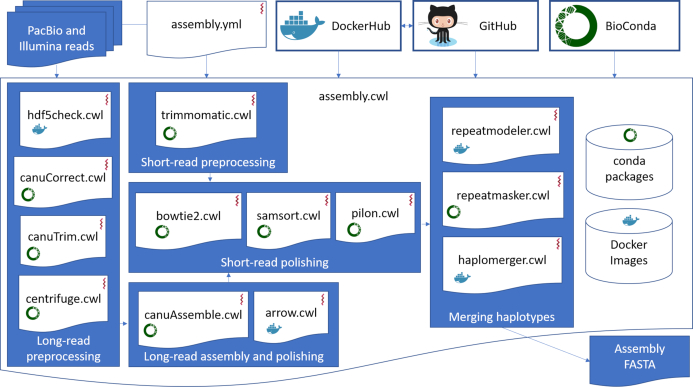
Diagram illustrates an automated common workflow language (CWL)-based genome assembly pipeline for PacBio long-read and Illumina short-read data. PacBio reads are first pre-processed and then used for assembly and long-read polishing. Illumina reads are cleaned and used to further polish the long-read assembly. Finally, haplotypes are merged in the repeat-masked, polished assembly. While the workflow is running, dependent software tools are automatically deployed from Bioconda package channel and DockerHub container repository. The code for the workflow and the Dockerfiles for the docker containers are stored in a GitHub code-repository.